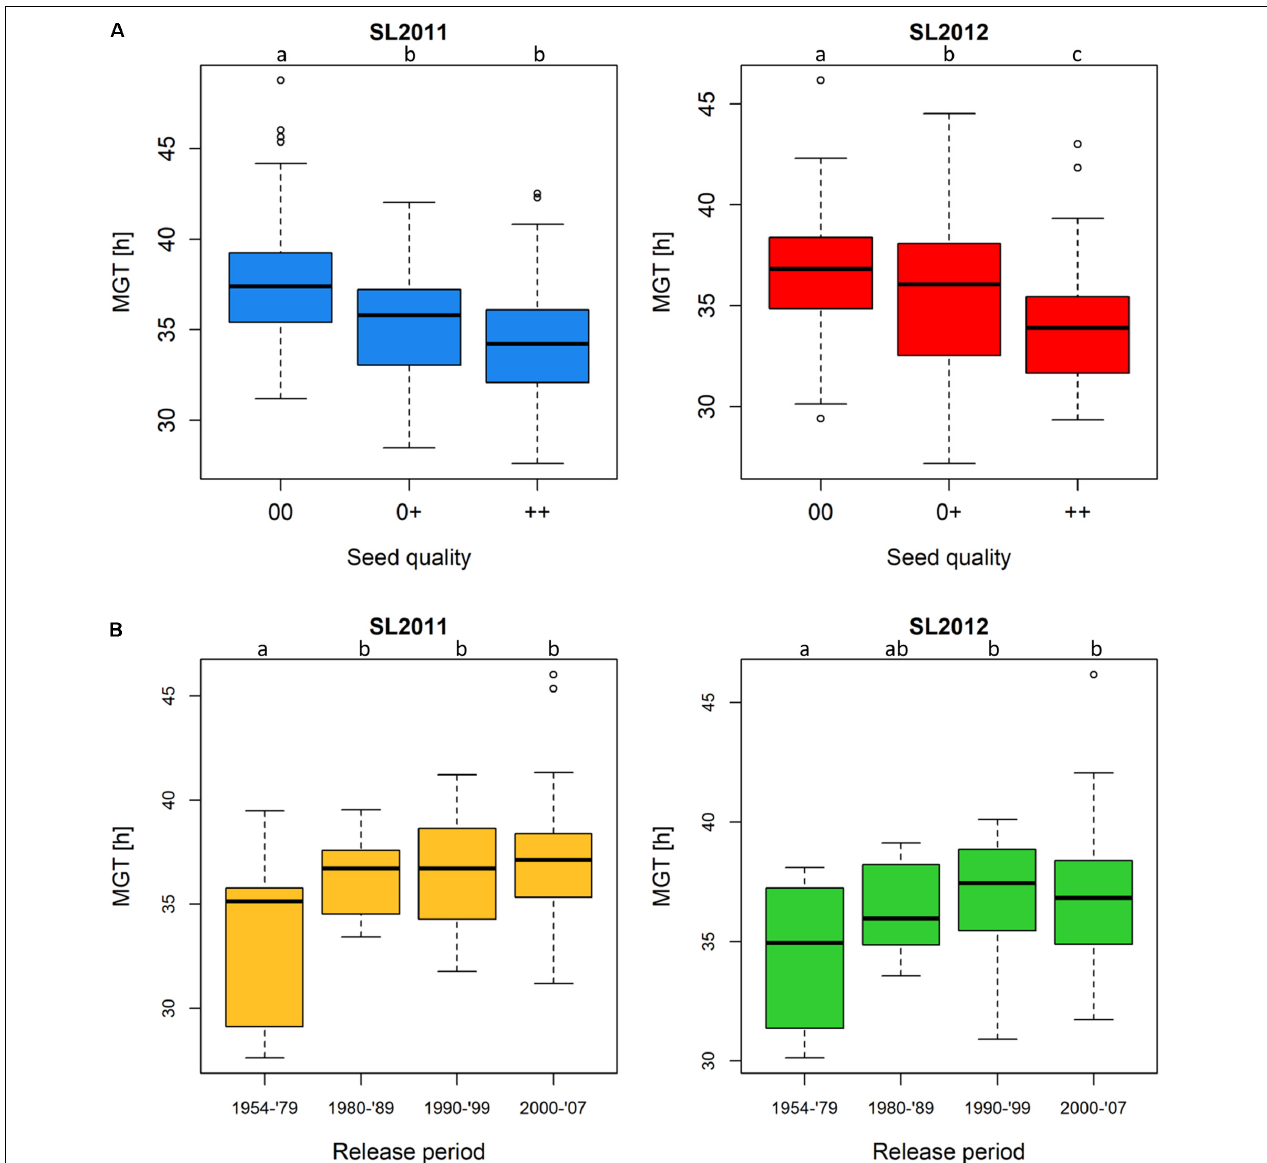
FIGURE 3 | Boxplots showing germination performance in a diverse set of winter oilseed rape genotypes. (A) Mean germination time (MGT) of genotypes classified by seed quality: 00, low erucic acid, low glucosinolate content; 0+, low erucic acid, high glucosinolate content; ++, high erucic acid, high glucosinolate content. (B) MGT of genotypes classified by their release periods: 1954–1979 (comprising ++ and 0+ genotypes solely), 1980–1989 (comprising ++, 0+ and 00 genotypes), 1990–1999, and 2000–2007 (00 genotypes only). Significant differences were calculated at a level of p < 0.1. Significance groups were indicated as